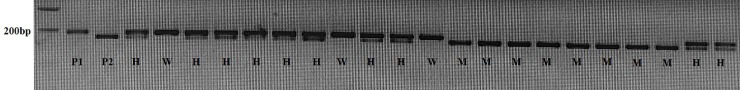
dCAPS analysis of lp1-3 allele in the F2 population derived from a cross between Sanggol and Ilpum.P1, ‘Ilpum’; P2, ‘Sanggol’; W, homozygous wild type; M, homozygous mutant; H, heterozygous.